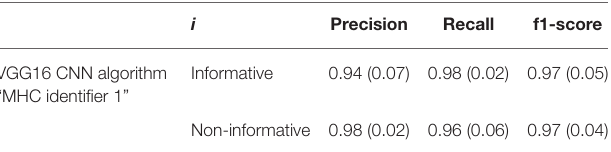
TABLE 2 | Classification metrics for precision, recall, and f1-score, with i ∈ C (informative, non-informative).